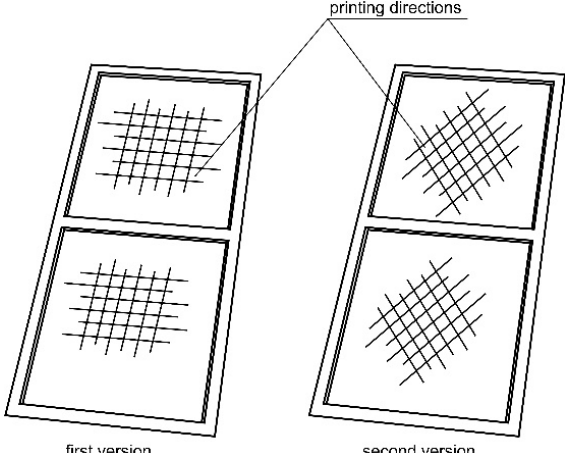
Figure 12. Model printout structure diagram.